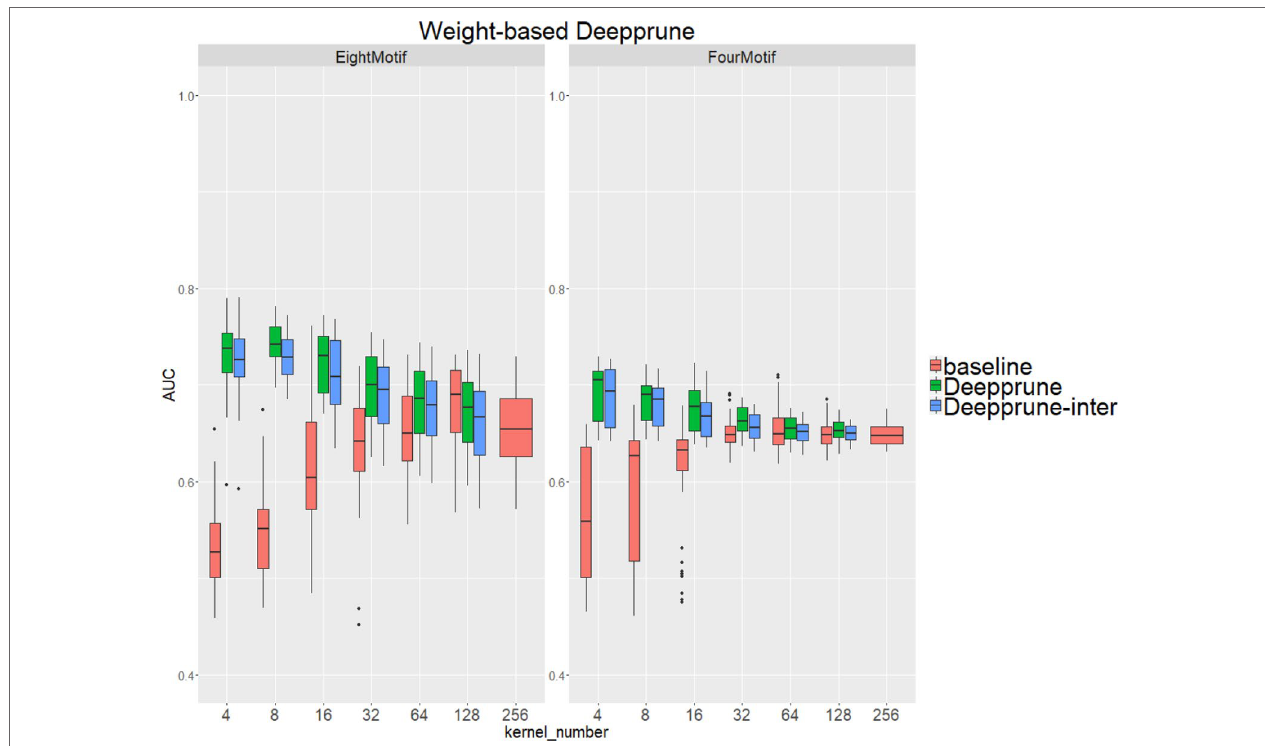
FIGURE 3 | Weight-based Deepprune performs much better and is much robuster to different random initialization than baseline when kernel number is limited in the last two complex simulated datasets, even when kernel number is half the motif number at which time the performance of Deepprune only drops